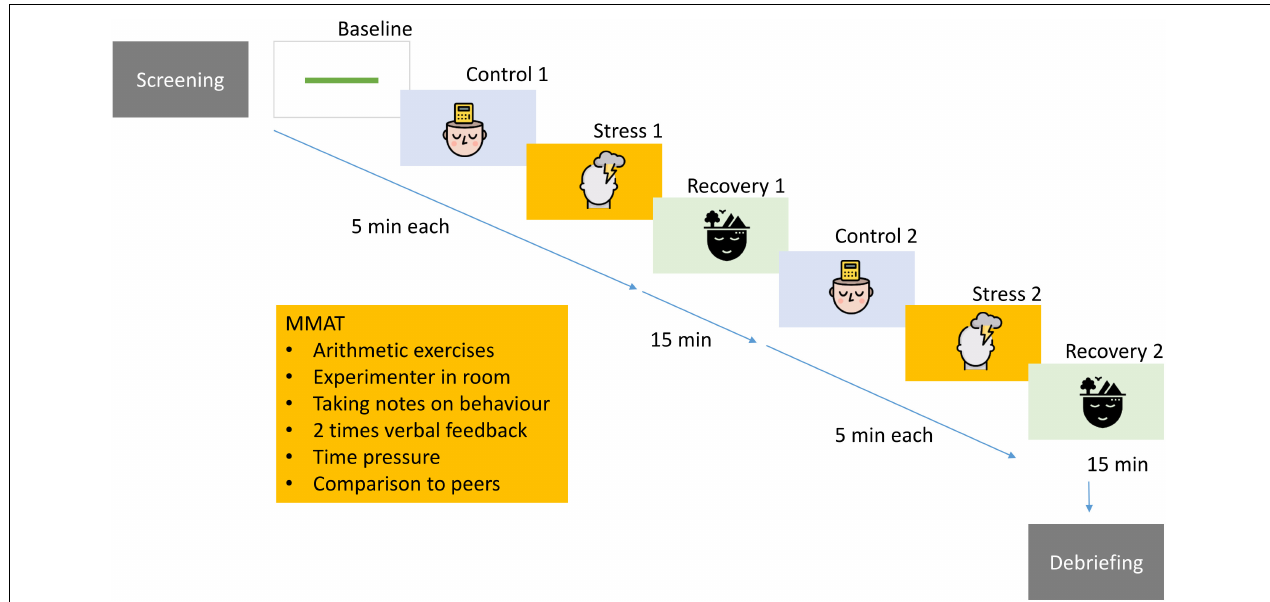
FIGURE 1 | Participants underwent extensive psychological screening and completed a computerized, repeated version of the mental arithmetic stress task including social evaluative components. This procedure was administered twice in one session. For a complete description see Supplementary Information A . Design: “images: Flaticon.com.” This figure has been designed using resources from Flaticon.com. Stress icons created by Freepik – Flaticon (https://www.flaticon.com/free-icons/stress). Psychology icons created by iconixar – Flaticon (https://www.flaticon.com/free-icons/psychology). Calm icons created by Becris – Flaticon (https://www.flaticon.com/free-icons/calm).